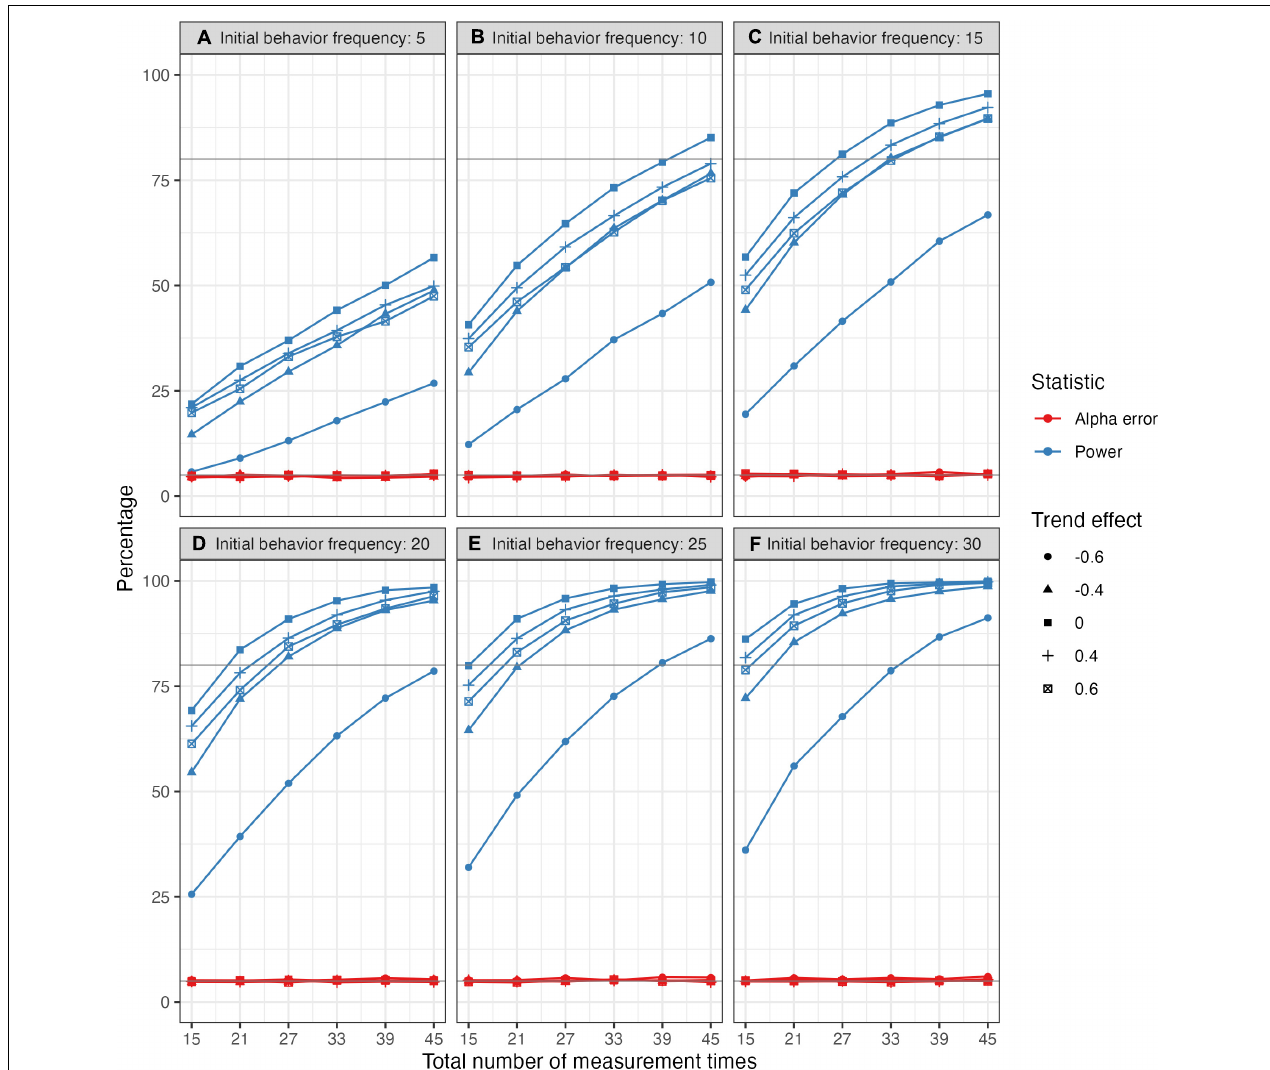
FIGURE 5 | Power and alpha error probability (line colour) for trend effects (dot shape), initial behavior frequency (part), and number of measurement times ( x -axis) (simulation